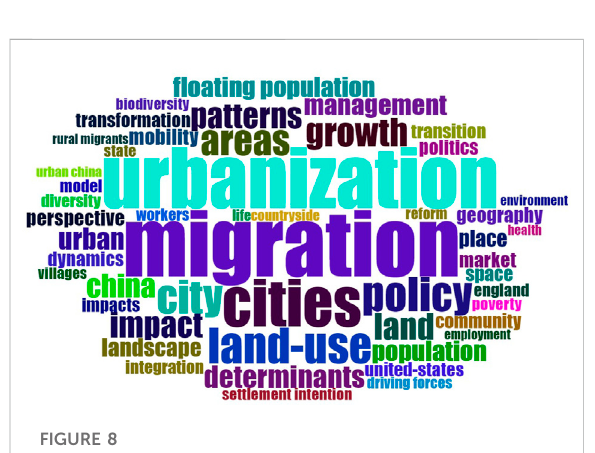
Rural settlements fi eld high -frequency keyword cloud